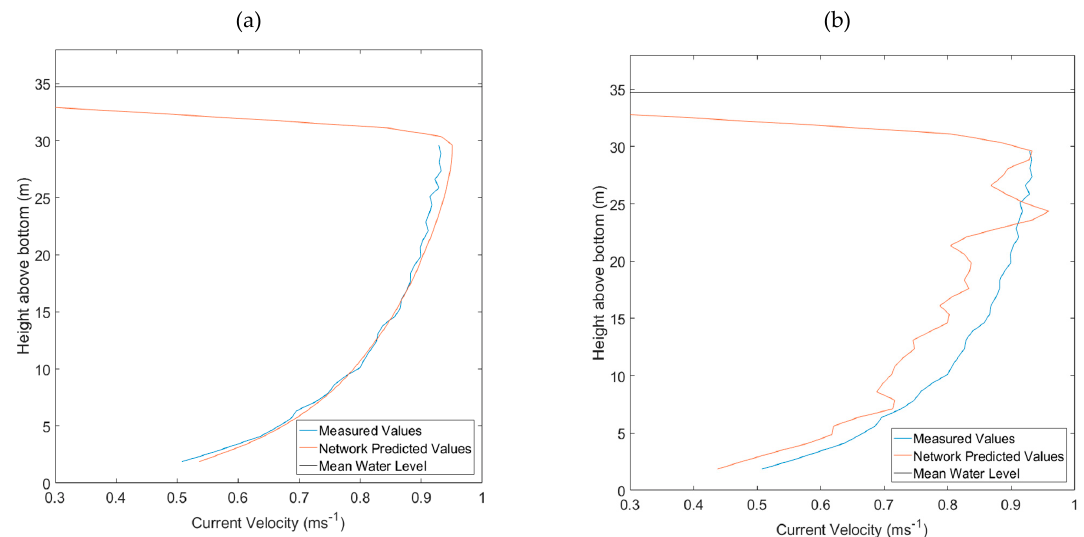
Figure 3. ( a ) Current velocity profile using the BR training function. ( b ) Current velocity profile using the GDA function. Blue: measured values, orange: network prediction, and black: mean water level. Table 3. r and ME of the different trained functions on the predictions of vertical velocity profiles. Function